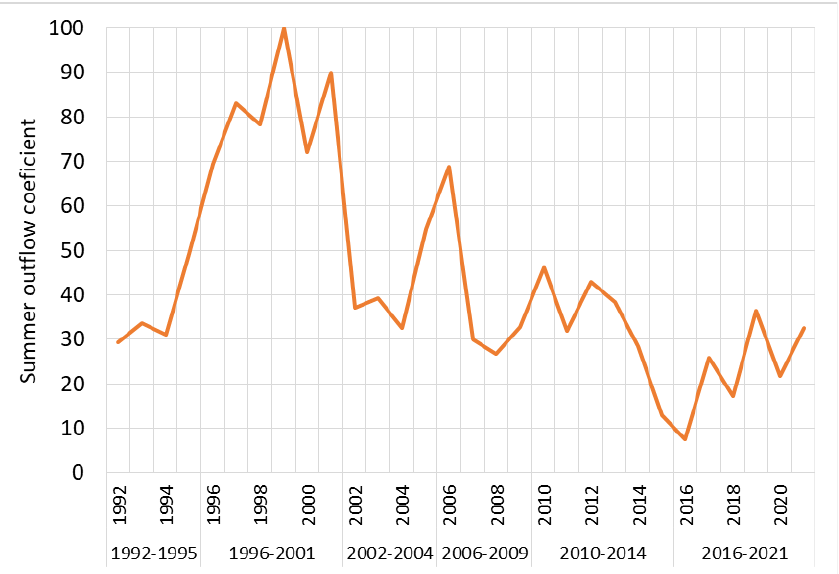
Figure 9. Summer outflow coefficients of the watershed on the experimental catchment UDL with periods divided by the double mass curve (Figure 8, Table 1). The outflow sum in 1999 was increased by a late snowmelt in May.